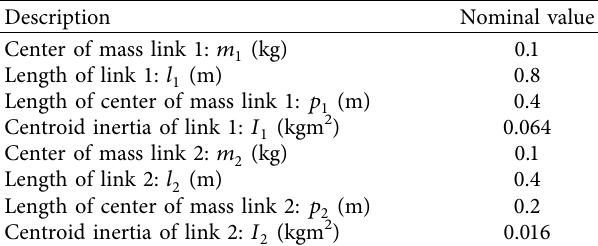
Figure 2: Two-link robotic manipulator plant with contact force at tip. Table 1: Variables description of the two-link robotic